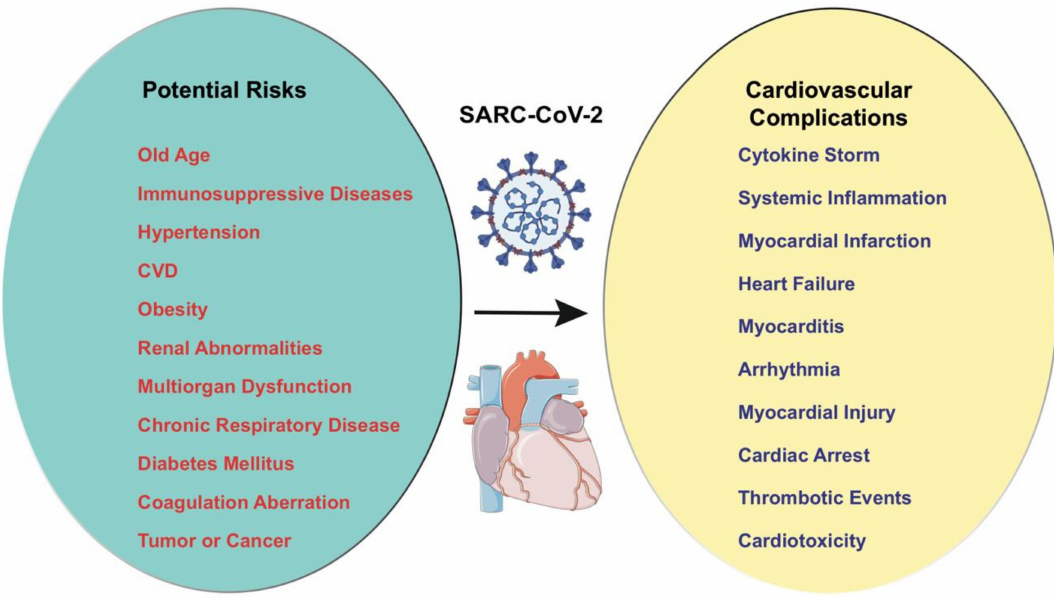
Figure 1. The potential risk factors and the cardiovascular complications in COVID-19. The possible risk factors are old age, immunosuppressive diseases, hypertension, CVD, chronic respiratory disease, obesity, renal abnormalities, diabetes mellitus, coagulation aberrations, and tumor. COVID-19-induced cardiovascular complications can be myocardial infarction, cytokine storm, heart failure, systemic inflammation, myocarditis, arrhythmia, myocardial injury, cardiac arrest, thrombotic events, and